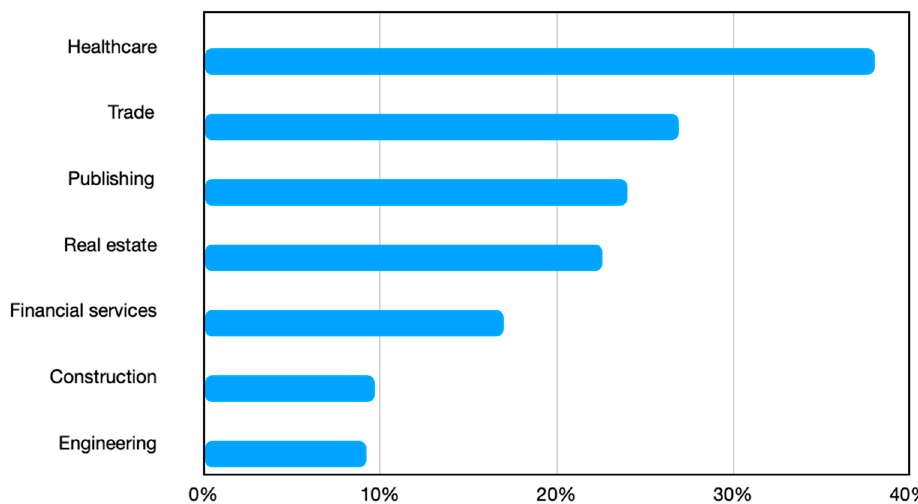
Figure 5. Percentage of women in leadership positions per industry in Germany. Source: statista.com, accessed on 10 September 2021.